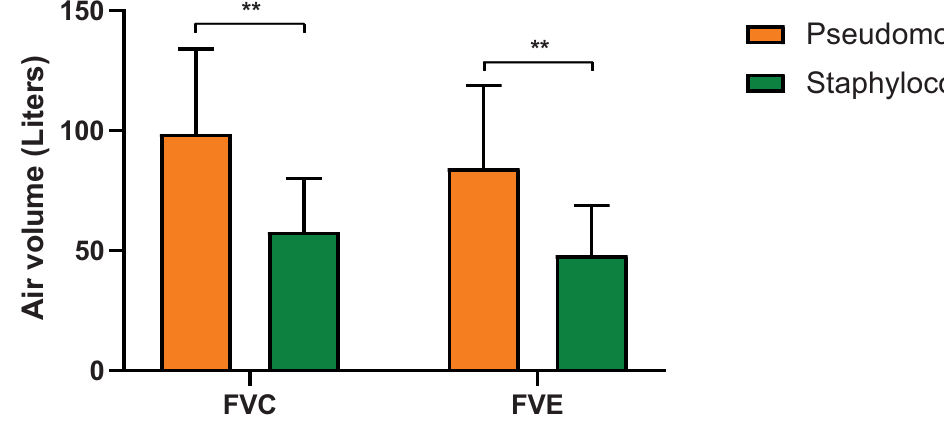
Fig 3. Comparison between pathogens showing decreased forced vital capacity and forced expiratory volume in patients in the Staph group. Forced vital capacity = FVC; forced expiratory volume in one second = FVE. Bars represent the average of the air volume, ( �� ) means significant difference among treatments by Mann-Whitney test ( P < 0.05), n = 20 per group.